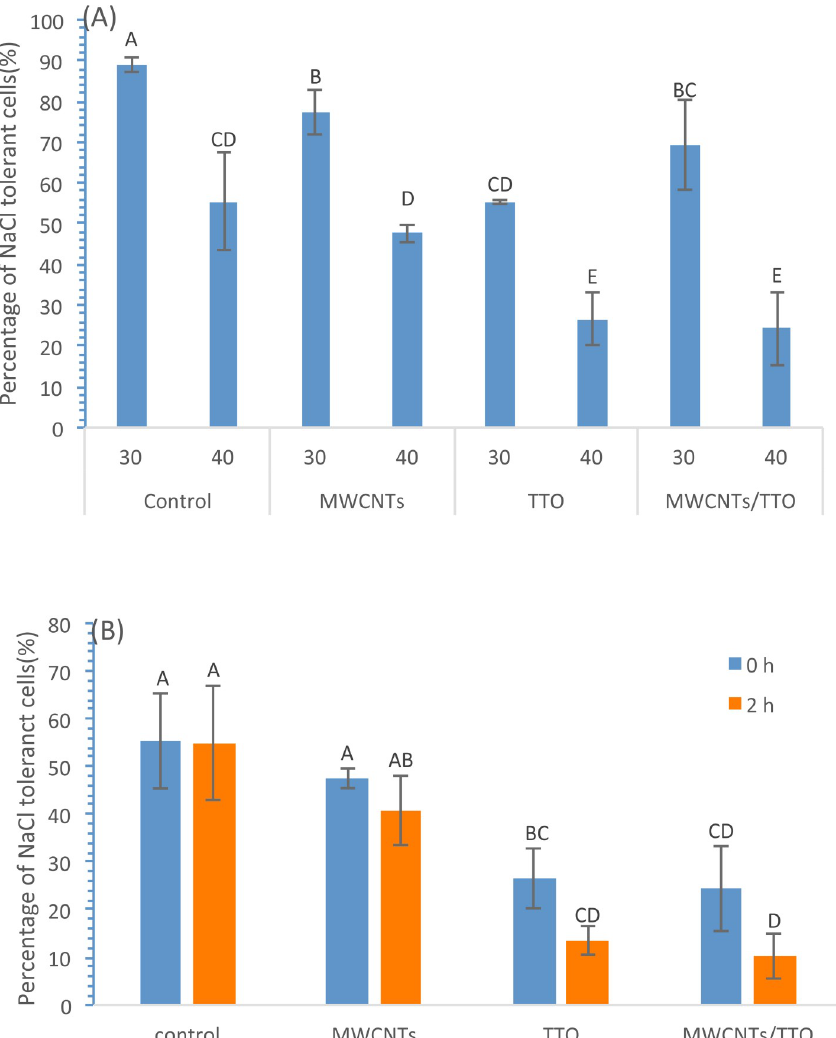
Fig 5. The percentage of NaCl tolerant E . coli cells retained on filters. (A) The cells without incubation step on the filters were immediately tested on LB agar plates supplemented with 30 and 40 g/L NaCl. (B) The cells after 0 and 2 h incubation on the filters were tested on LB agar plates supplemented with 40 g/L NaCl. Notes: Statistical analysis results are indicated by the letters on the bars. Different letters above the bars indicate statistical difference between the results (P < 0.05); Identical letters above the bars indicate no statistical